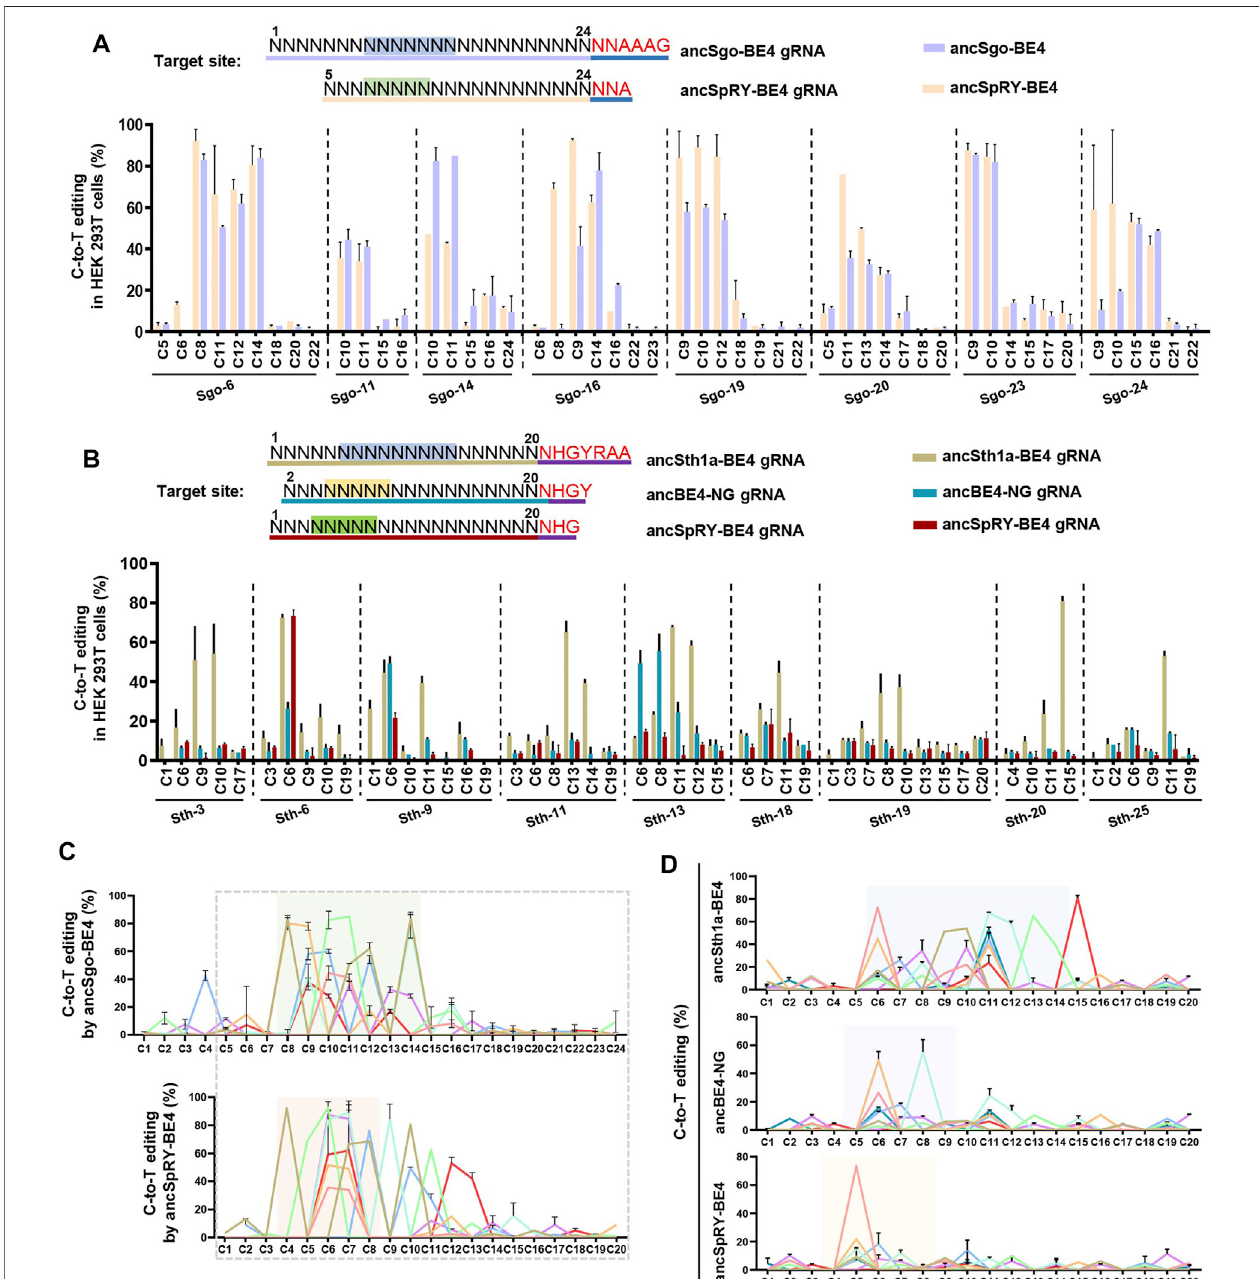
FIGURE 4 | Comparison of ancSgo-BE4 and ancSth1a-BE4 with ancSpRY-BE4 and/or ancBE4-NG. (A) Summary of C-to-T editing ef fi ciencies induced by ancSgo-BE4 and ancSpRY-BE4 in HEK293T cells. The upper panel presents the designed target sites with NNAAAG PAM (highlighted in red) to be compatible with SgoCas9 and SpRYCas9 gRNA simultaneously. The most distal nucleotide of ancSgo-BE4 gRNAs relative to NNAAAG within protospacer was set as position “ 1. ” (B) Summary of C-to-T editing ef fi ciencies induced by ancSth1a-BE4, ancBE4-NG, and ancSpRY-BE4 in HEK293T cells. The upper panel presents the designed target sites with NHGYRAA PAM (highlighted in red) to be compatible with Sth1aCas9, Cas9-NG (HGY PAM), and SpRYCas9 (NHG PAM) gRNAs simultaneously. The most distal nucleotide of ancSth1a-BE4 gRNA relative to NHGYRAA within protospacer was set as position “ 1. ” (C,D) The editing ef fi ciencies from all tested targeting sites were integrated for ancSgo-BE4 and ancSpRY-BE4 (C) as well as ancSth1a-BE4, ancBE4-NG, and ancSpRY-BE4 (D) , respectively. The dotted box presents the overlapping sequences for their gRNAs, and the colored box highlights the editing window for each CBEs, respectively.